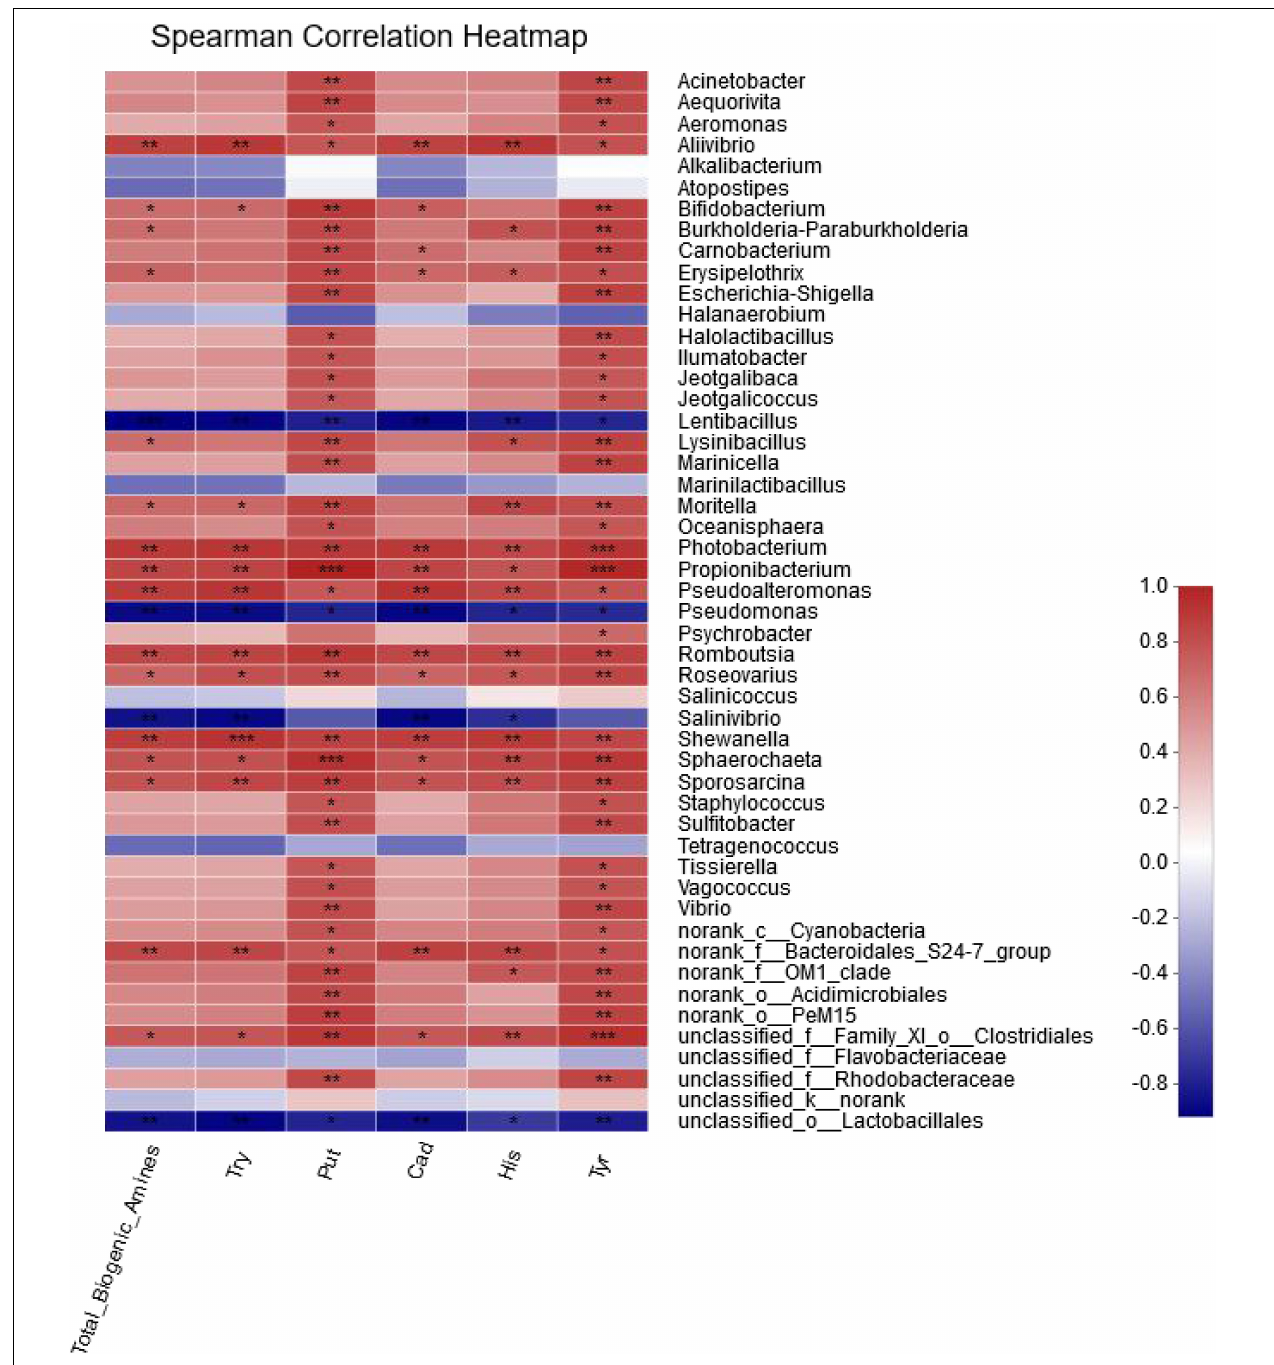
FIGURE 5 | The correlation between bacterial community and biogenic amines in different fermentation times.